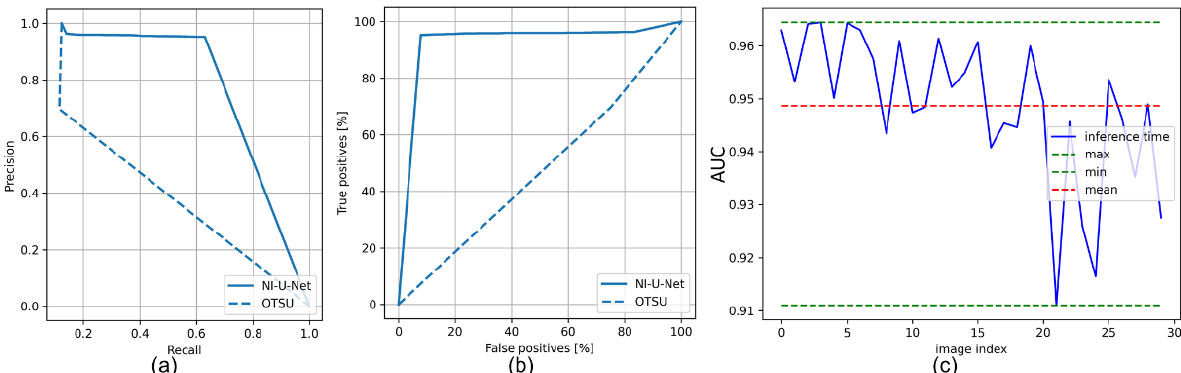
Figure A9. The ROC, POR, and AUC curves of proposed NI-U-Net using the 30 evaluation scenes. ( a – c ) refer to ROC, POR, and AUC curves, respectively. The OTSU algorithm is implemented using the “cv2.THRESH_OTSU” of OpenCV library. The proposed NI-U-Net show better performance than the OTSU algorithm in both ( a , b ). The proposed NI-U-Net show better performance in both ( a , b ). The AUC is calculated using the AUC metric in the TensorFlow library (with 200 thresholds). The red dash line in ( c ) refers to the average AUC value of the NI-U-Net, 94.7%.